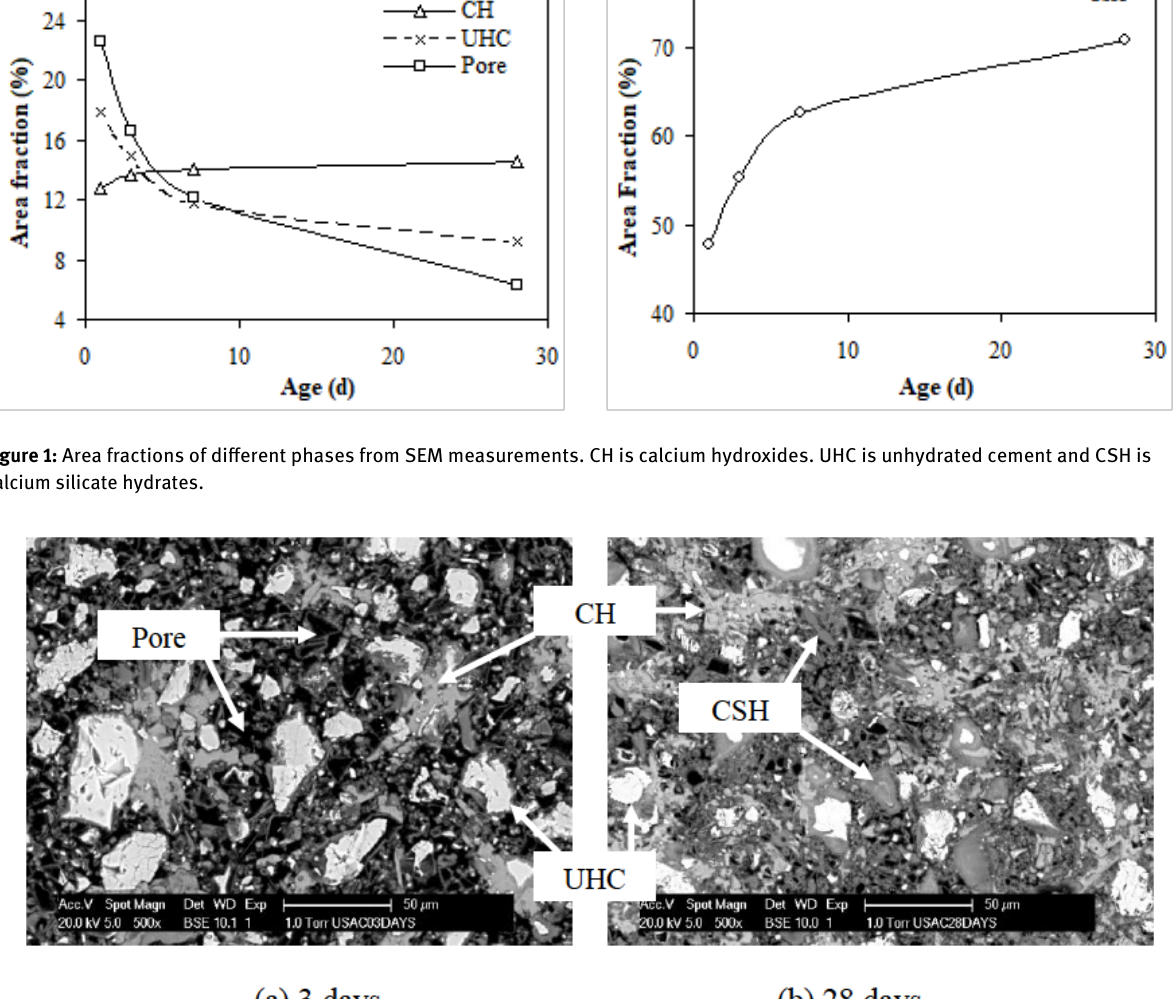
calcium hydroxides (CH) increases very slightly during the period from 1 day to 28 days. It can be explained that with the high w/c ratio, the ferrite can react with ettringite and CH to produce garnets [2]. It also can be caused by the uni- form distribution of CH, and thus the total observed area of the samples is not sufficient to achieve the correct frac- tion of CH [2]. The porosity decreases significantly during the hydration of the first 7 days. At the age of 28 days, the porosity is only 9%. What should be mentioned is that gel porescannotbeobservedbyaBSEdetectorwith500Xmag- nification. The fraction of pores shown in Figure 1 only in- cludes the capillary pores of which the size is lager than hundreds of nanometers depending on the